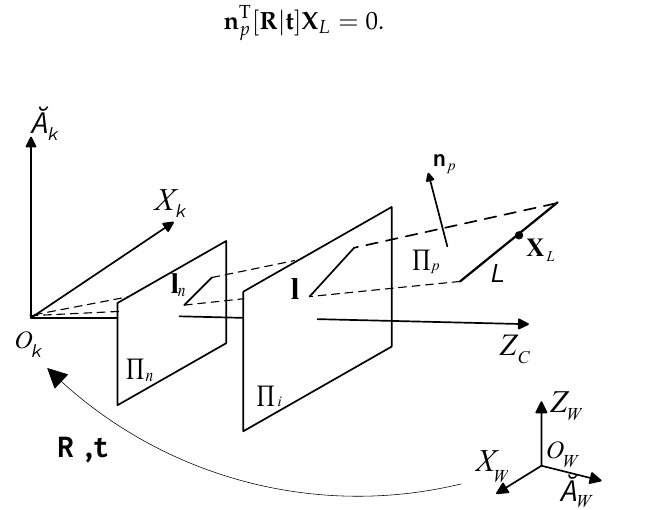
Figure 6. Geometry of camera projection model. Π i is the image plane,. Π n is the normalized image plane, and Π p is the interpretation